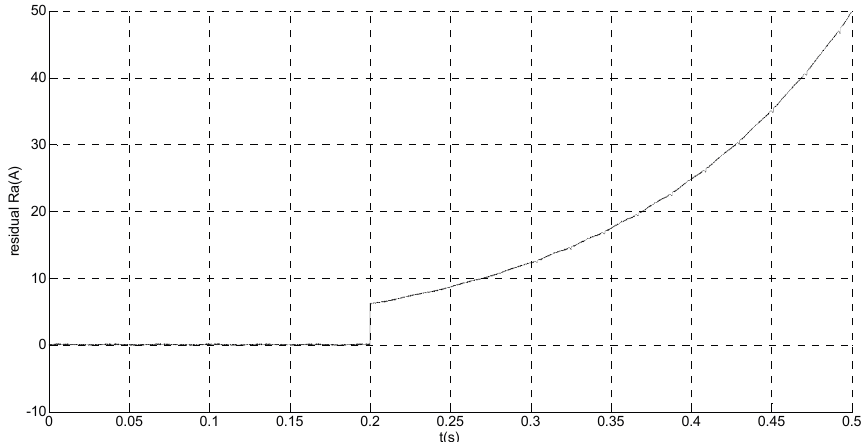
Figure 20. Simulation results of the actual and observation of β axis stator current.